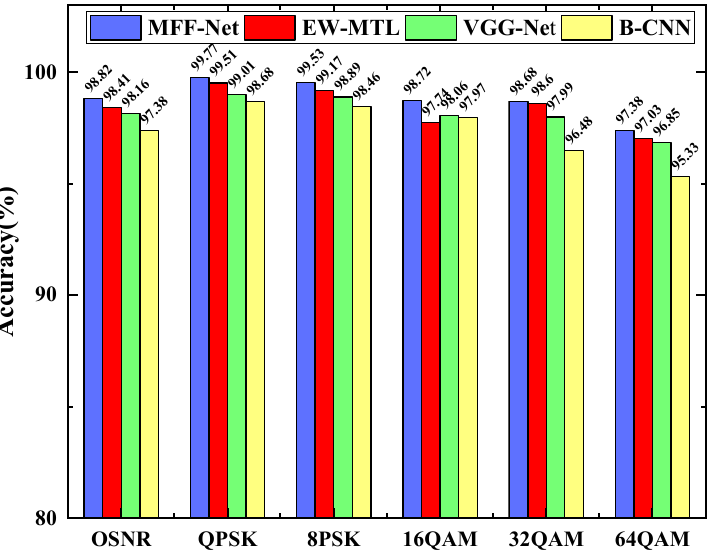
Figure 8. OSNR monitoring accuracy between MFF-Net and the other three algorithms.